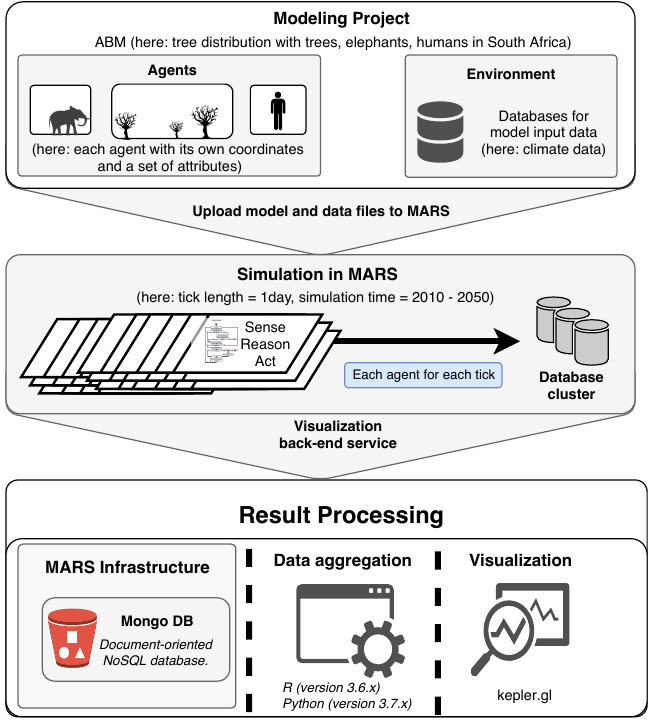
Figure A1. Illustration of technical workflow from model initialization to result storage.